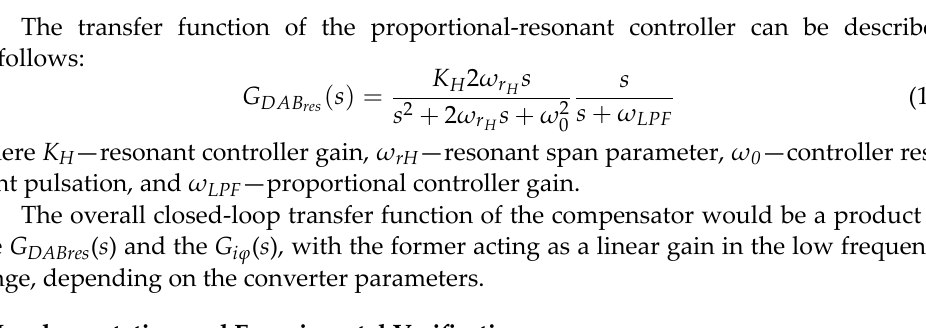
Figure 7. Control algorithm with DC link pulsation estimation algorithm.